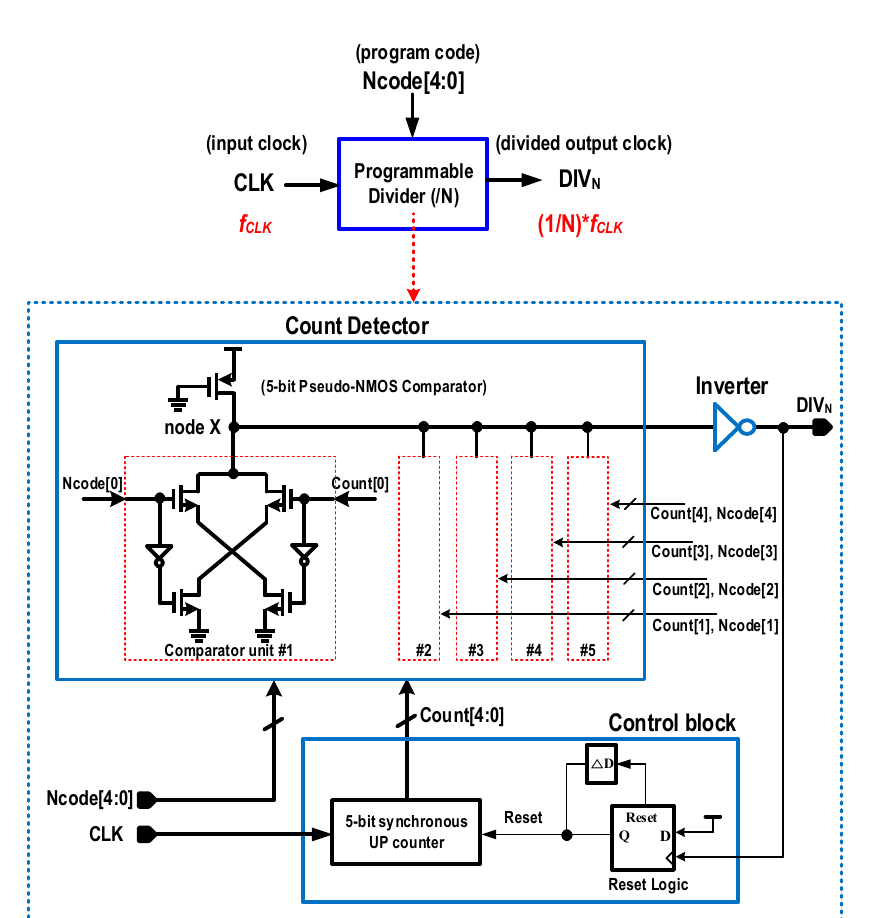
Figure 6. Proposed Pseudo ‐ NMOS comparator ‐ based programmable divide ‐ by ‐ N divider.